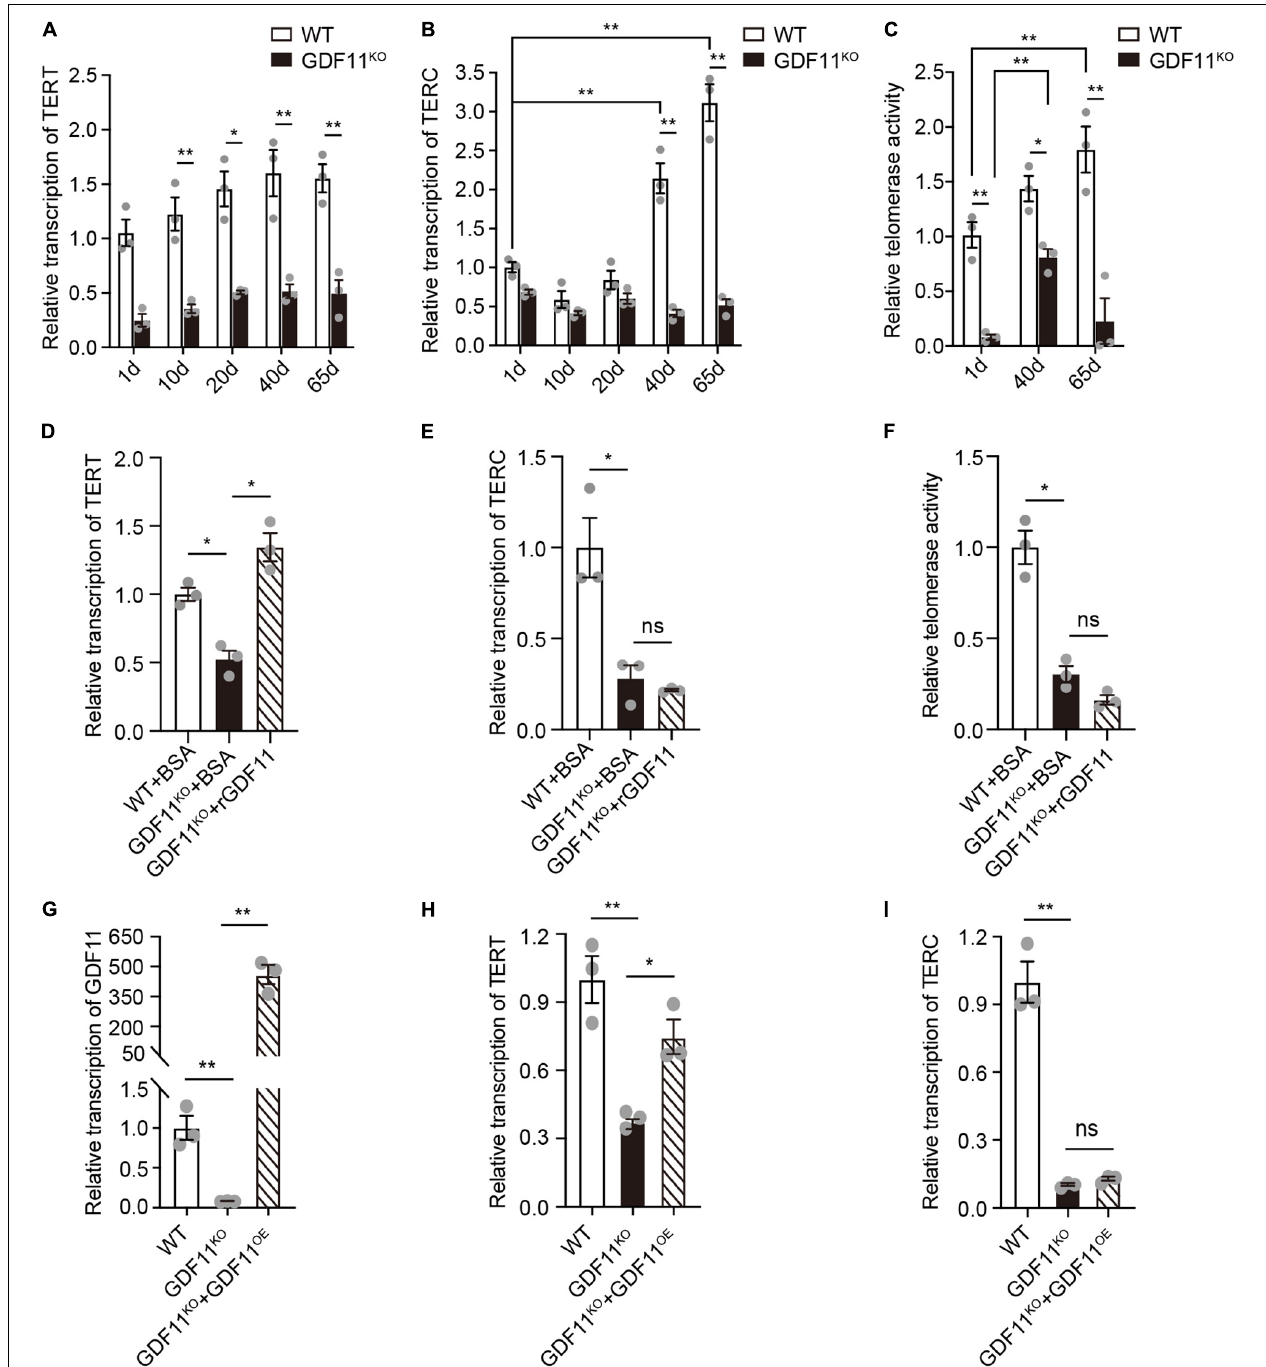
FIGURE 3 | In vitro loss of GDF11 downregulates TERT, TERC, and telomerase activity. Quantification of the mRNA level of telomerase reverse transcriptase (TERT, A ) (two-way ANOVA, interaction: F ( 4 , 20 ) = 0.4232, p = 0.7901; WT vs. GDF11 KO : F ( 1 , 20 ) = 153.1, p < 0.0001; time: F ( 4 , 20 ) = 3.983, p = 0.0155; Sidak’s test, 1 day: WT vs. GDF11 KO , p = 0.0007; 10 days: WT vs. GDF11 KO , p = 0.0003; 20 days: WT vs. GDF11 KO , p < 0.0001; 40 days: WT vs. GDF11 KO , p < 0.0001; 65 days: WT vs. GDF11 KO , p < 0.0001; n = 3 per group) and telomerase RNA component (TERC, B ) (two-way ANOVA, interaction: F ( 4 , 20 ) = 43.49, p < 0.0001; WT vs. GDF11 KO : F ( 1 , 20 ) = 185.5, p < 0.0001; Time: F ( 4 , 12 ) = 39.47, p < 0.0001; Sidak’s test, 40 days: WT vs. GDF11 KO , p < 0.0001; 65 days: WT vs. GDF11 KO , p < 0.0001; WT: 1 vs. 40 days, p < 0.0001; WT: 1 vs. 65 days, p < 0.0001; n = 3 per group) as well as the telomerase activity (C) (two-way ANOVA, interaction: F ( 2 , 12 ) = 5.662, p = 0.0186; WT vs. GDF11 KO : F ( 1 , 12 ) = 80.51, p < 0.0001; time: F ( 2 , 12 ) = 9.197, p = 0.0038; Sidak’s test, 1 day: WT vs. GDF11 KO , p = 0.0017; 40 days: WT vs. GDF11 KO , p = 0.0265; 65 days: WT vs. GDF11 KO , p < 0.0001; WT: 1 vs. 65 days, p = 0.0067; GDF11 KO : 1 vs. 40 days, p = 0.0104; n = 3 per